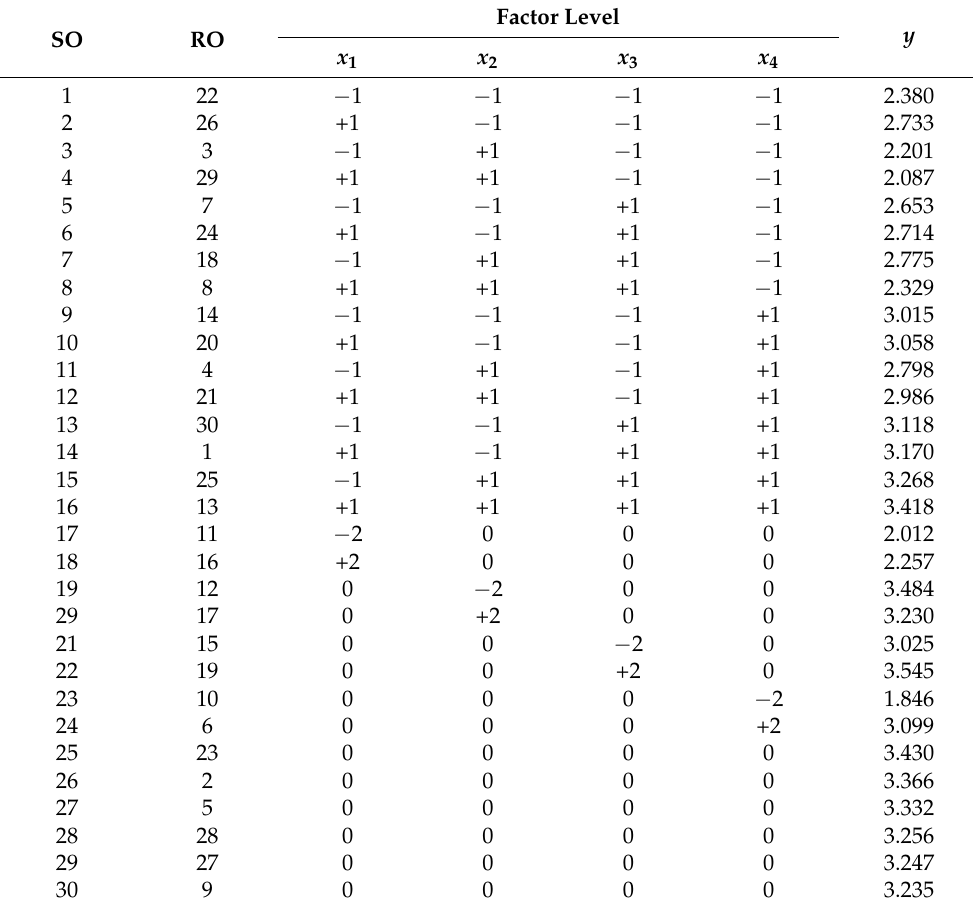
Table 2. Experimental design layout and observed response ( y ). SO and RO are the standard and the run order of